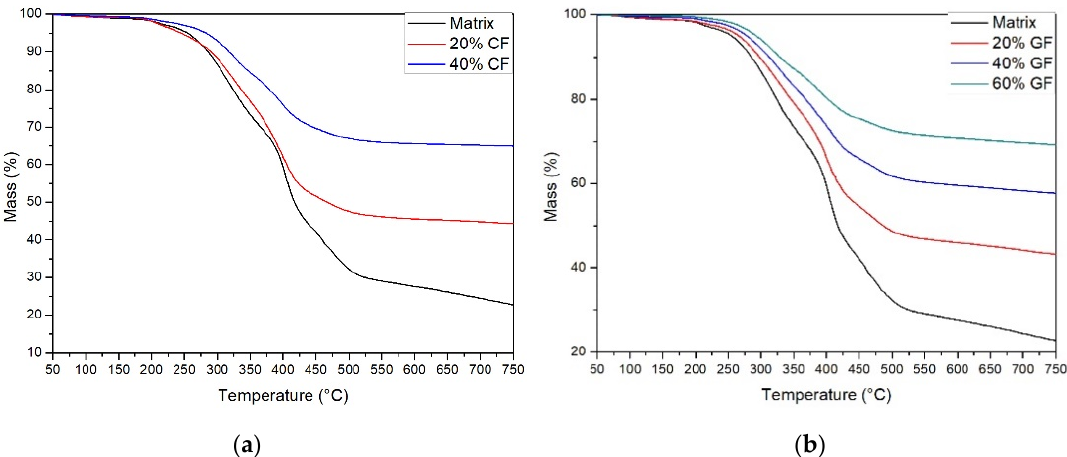
Figure 4. TGA curves of composites ( a ) carbon fiber, ( b ) glass fiber.